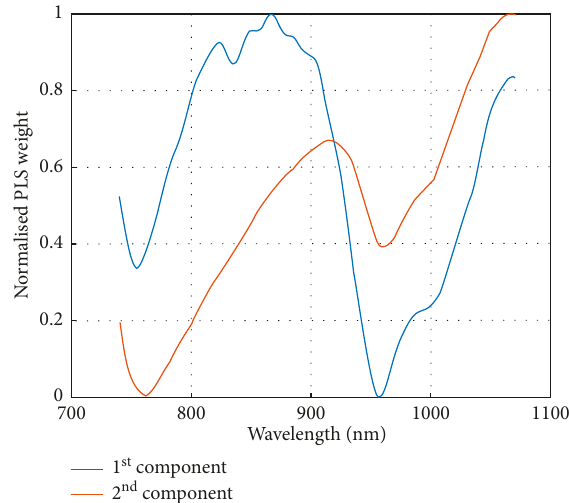
Figure 5: PLS loading weights versus wavelength of the top two latent